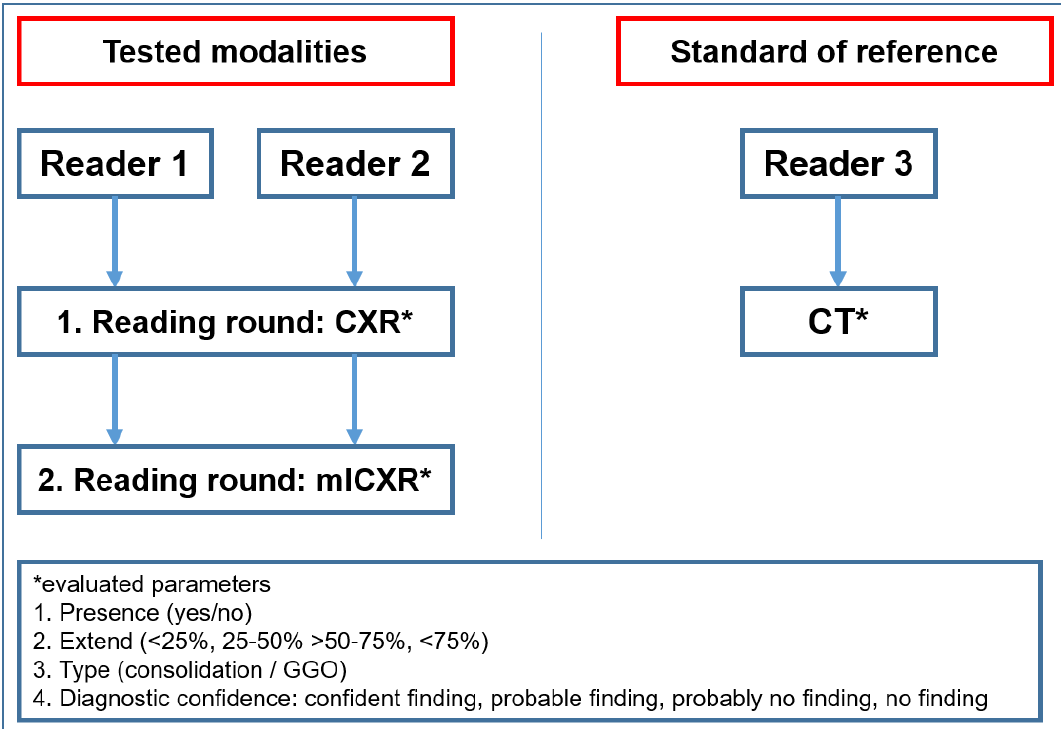
Figure 1. Image evaluation: Reader 1 and Reader 2 evaluated the conventional radiography images (CXR) and the machine learning conventional radiography (mlCXR). Reader 3 evaluated the standard of reference computed tomography images (CT). Evaluated imaging parameters were presence (yes/no) and extend and typo of parenchymal changes (consolidation or ground glass opacities (GGO)). Further, readers had to state the confidence level of their diagnosis. In all steps, images of n = 60 patients were evaluated.